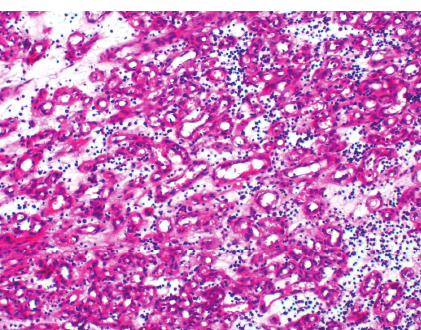
Figure 3: The vascular channels lined by a single layer of endothe- lium surrounded with lymphomononuclear cells (hematoxylin and eosin stain, original magnification ×